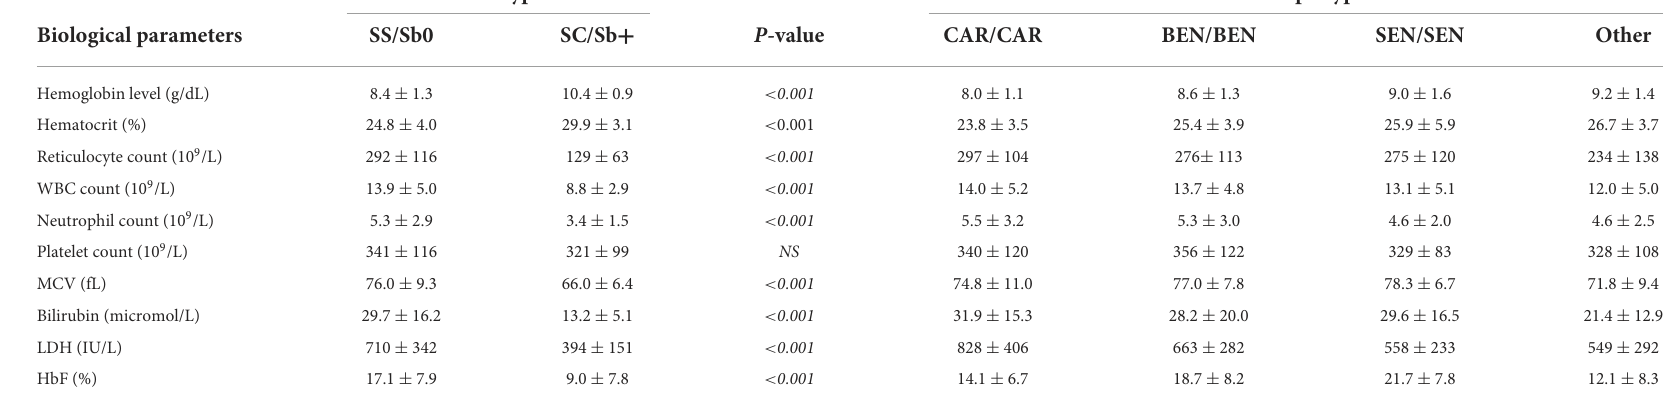
TABLE 1 Baseline biological parameters in SCD patients, according to genotype (SCA vs. SC/Sb + ) and beta-haplotype